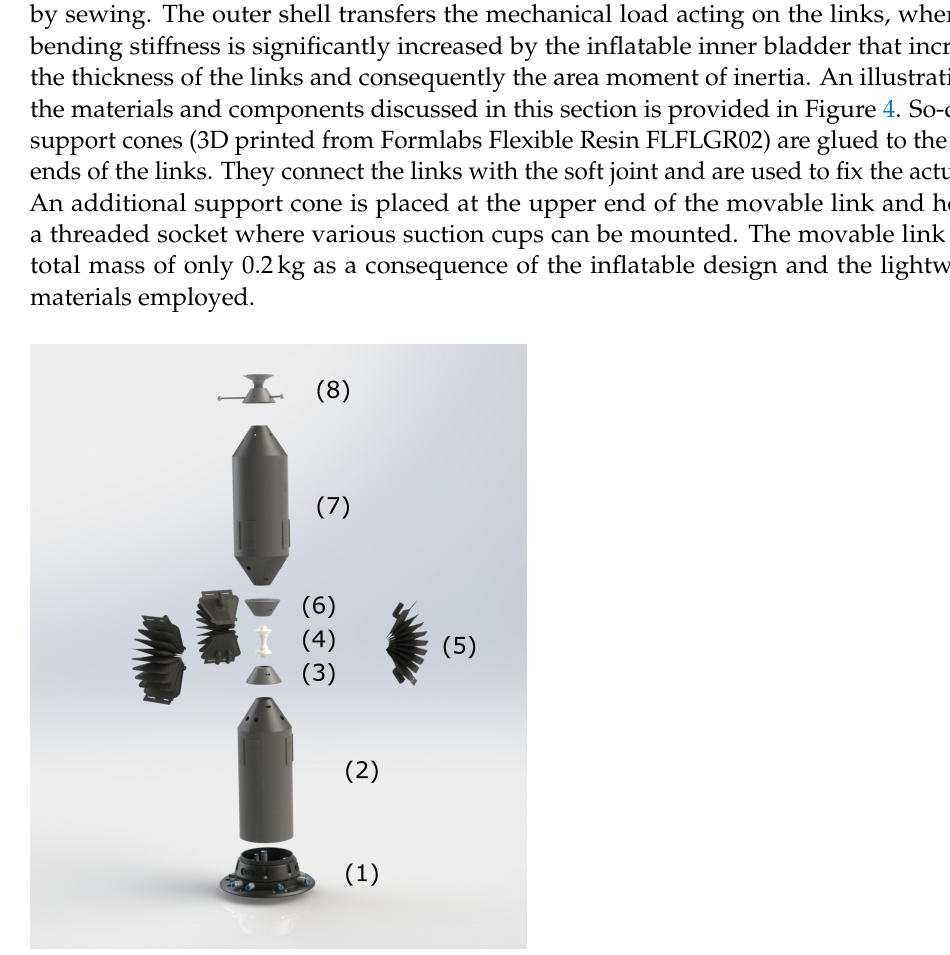
Figure 3. Explosion view of the inflatable robotic arm: The base plate (1) mounts the outer shell of the static link (2) and features tubing connectors that allow to route the tubing internally. The conic support (3) is glued to the interior of the static link and supports the soft joint (4). The three bellow actuators (5) are arranged symmetrically around the soft joint. Tubing is connected through elbow connectors that fit into circular openings in the static and movable links. Additionally, the actuators are fixed by strings attached to the conic supports and Velcro straps on the outer shells of the links. A second conic support (6) connects to the soft joint and is glued to the movable link (7). A third conic support (8) is mounted on the top end of the movable link and houses the suction cup and the markers for the motion capture system. The tubing, the inner bladders, the strings for mounting the actuators, and the screws are not shown for better